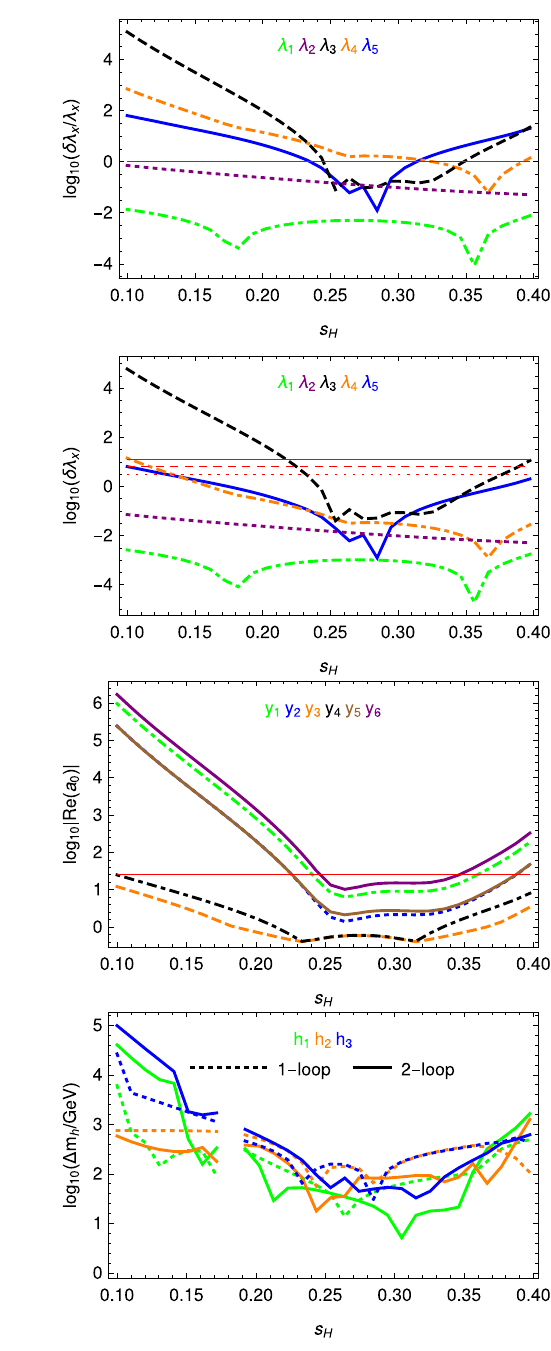
Fig. 3 The relative (first row) and absolute (second row) size of the counter-terms to the quartic couplings λ i as a function of s H . The third row gives the absolute value of different eigenvalues of the scattering matrix when using the renormalised quartic couplings as input. The fourth row shows the size of the one- and two-loop corrections to the